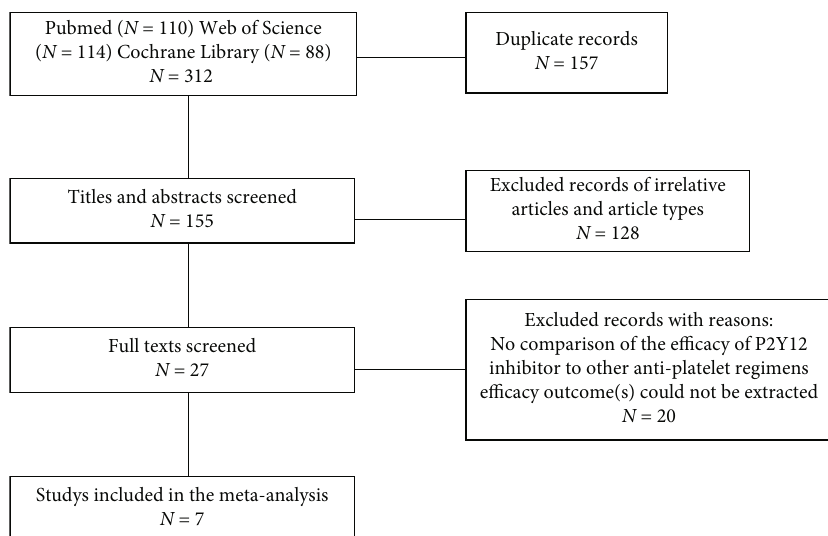
Figure 1: PRISMA fl ow chart for inclusion of eligible